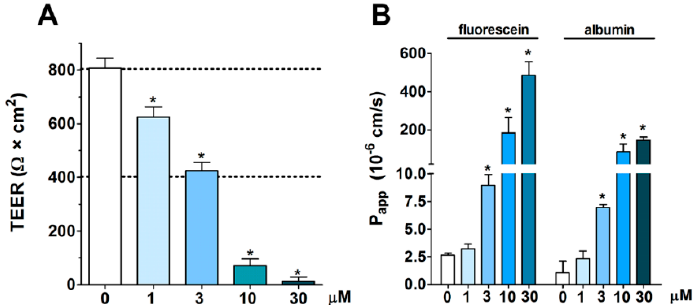
Figure 2. Effect of 1-h PN159 treatment on barrier integrity of Caco-2 cell layers. ( A ) Transepithelial electrical resistance (TEER). ( B ) Permeability for fluorescein and albumin marker molecules (P app A-B 10 − 6 cm/s). Values are presented as means ± SD, n = 3–8. Statistical analysis: ANOVA followed by Dunnett’s test, p < 0.05 as compared with the control groups.